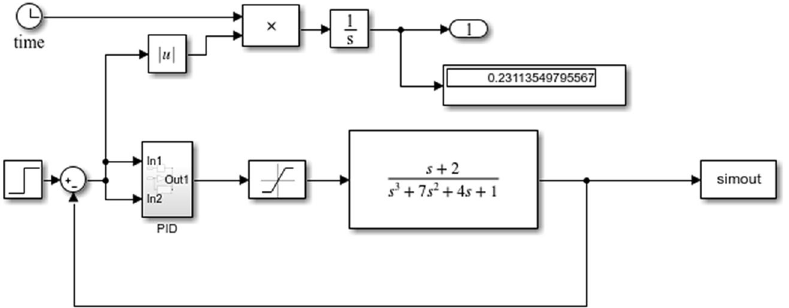
Figure 8. Diagram of wave compensation single channel Simulink control system.